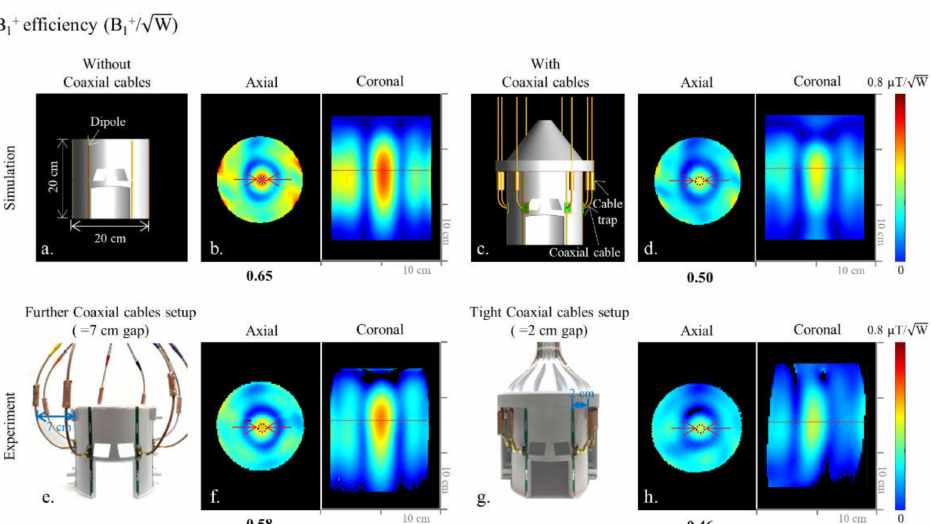
Figure 1. CAD models of the 8-channel inductor-shortened dipole antenna array without ( a ) and with ( c ) coaxial cable setups. Corresponding simulated B 1+ efficiency maps of the dipole antenna array are shown in ( b , d ), respectively. Photographs of the 8-channel inductor-shortened dipole antenna array with further ( e ) and tight ( g ) coaxial cable setups. Corresponding experimental B 1+ efficiency maps of the dipole antenna array are shown in ( f , h ),